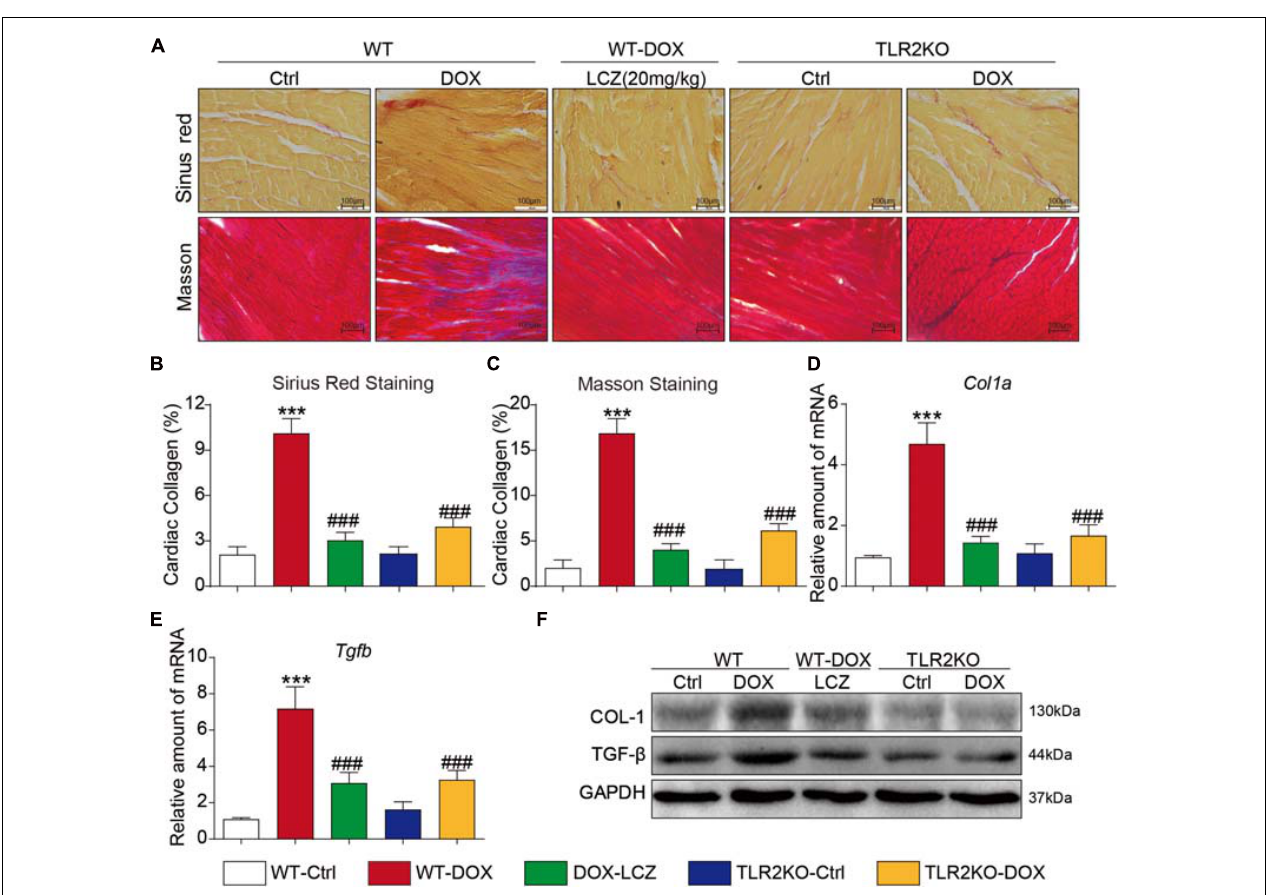
FIGURE 2 | LCZ696 treatment and TLR2 deficiency attenuated doxorubicin-induced cardiac fibrosis. (A) Representative images of Sirius Red and Masson trichrome staining of longitudinal sections of the hearts (200 × ). (B,C) Quantification of interstitial fibrotic areas (%) from Sirius Red-stained heart sections (B) and Masson’s Trichome staining (C) . (D,E) The mRNA levels of Col1a1 (D) and Tgfb (E) were detected by real-time PCR in the heart tissue from the above transplanted mice (data were normalized to Actb ). (F) Heart tissue from each group of mice was homogenized for western blot analysis of collagen I, TGF- β , and GAPDH. ( n = 7; *** P < 0.001 as indicated; ### P < 0.001 compared to Ang II; and ns is not significant).